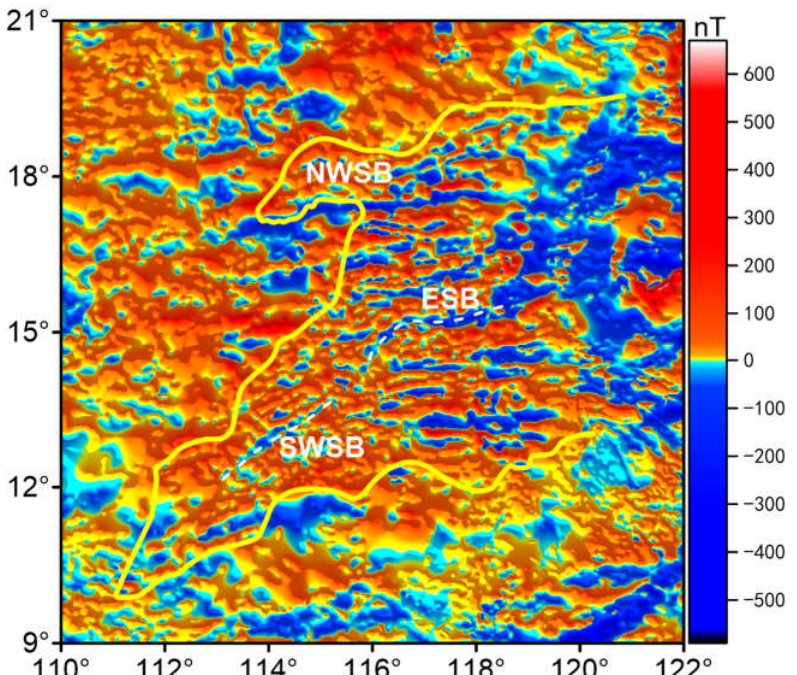
Figure 2. The magnetic anomalies of the South China Sea. The dashed white line denotes the position of the fossil spreading ridge. The solid yellow line denotes the continent-ocean boundary [35]. The magnetic anomaly data are from the Coordinating Committee for Geoscience Programs in East and Southeast Asia (CCOP).